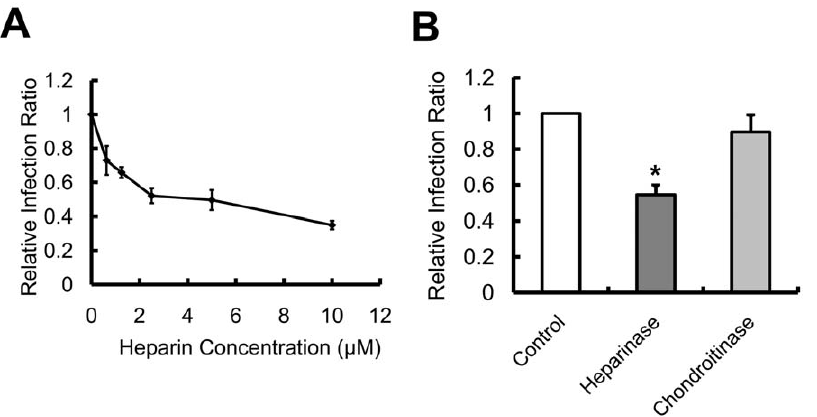
Figure 6. Incubation with heparin and degradation of HS polysaccharides on the cell surface by heparinase inhibits SARS pseudovirus infection of HEK293E/ACE2-Myc cells. ( A ) Heparin inhibits SARS pseudovirus entry into HEK293E/ACE2-Myc cells. Before incubation with SARS pseudovirus at 37 u C for 4 h, HEK293E/ACE2-Myc cells were treated with heparin for 10 min at the concentration of 0.625 m M, 1.25 m M, 2.5 m M, 5 m M or 10 m M. GFP-expressing HEK293E/ACE2-Myc cells in the total population were analyzed by flow cytometry. The relative viral infection ratio was measured by comparing the percentage of GFP expressing cells of each group to that of the BSA control. Error bars represent the SD of three independent experiments. ( B ) Lysis of cell-surface HS by heparinase blocks the infection of HEK293E/ACE2-Myc cells by SARS pseudovirus. After incubation with 10 U of heparinase I or chondroitinase ABC for 1 h at 37 u C, the cells were treated with SARS pseudovirus as described above. The relative viral infection ratio was calculated by the same method. *P , 0.05.